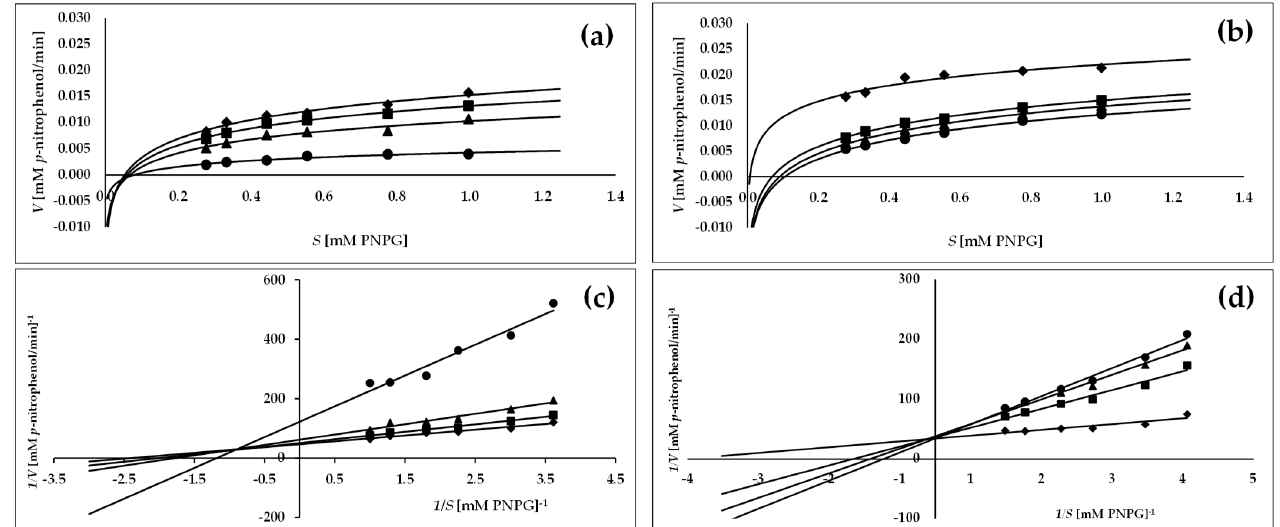
Figure 2. Michaelis–Menten plots ( a , b ) and Lineweaver–Burk plots ( c , d ) of methanol–water (7:3, v/v ) extract of C. bullatus leaves MBL ( a , c ) and acarbose ( b , d ) for inhibition of α -glucosidase; the MBL concentrations: ♦ —control (no inhibitor), —5.0 µg/mL, —6.0 µg/mL, • —9.0 µg/mL; the